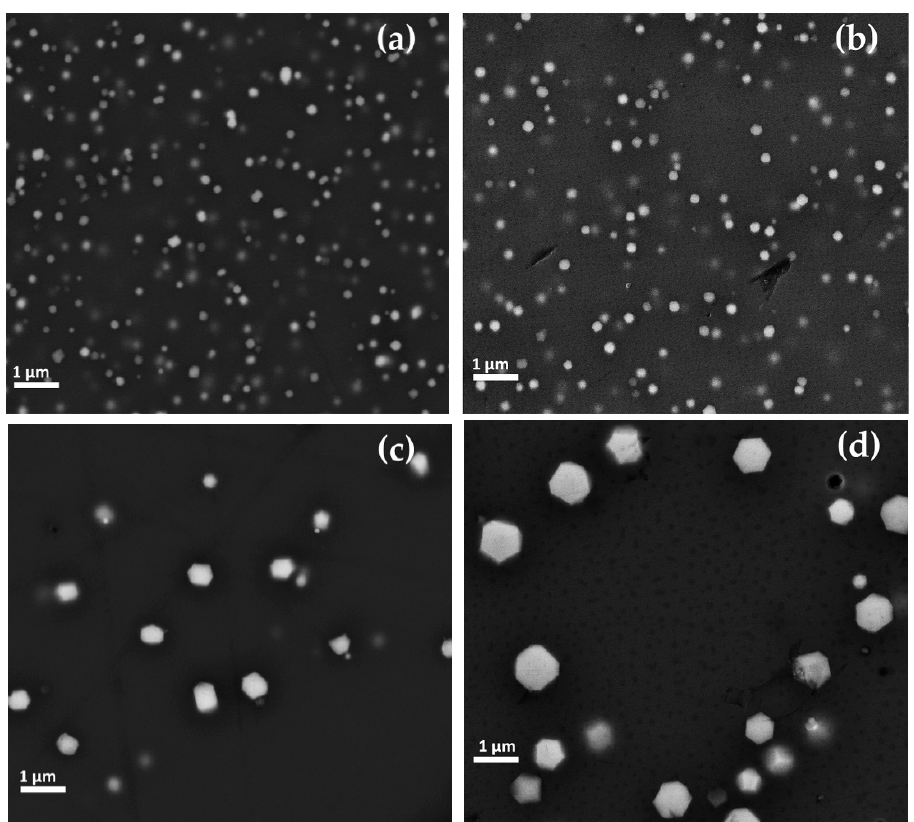
Figure 17. FEG–SEM micrographics of Gr-5 group samples—cuprite crystals observed in sample AR1 ( a ) and AR2 ( b ), AR8 ( c ) and AR4 ( d ).